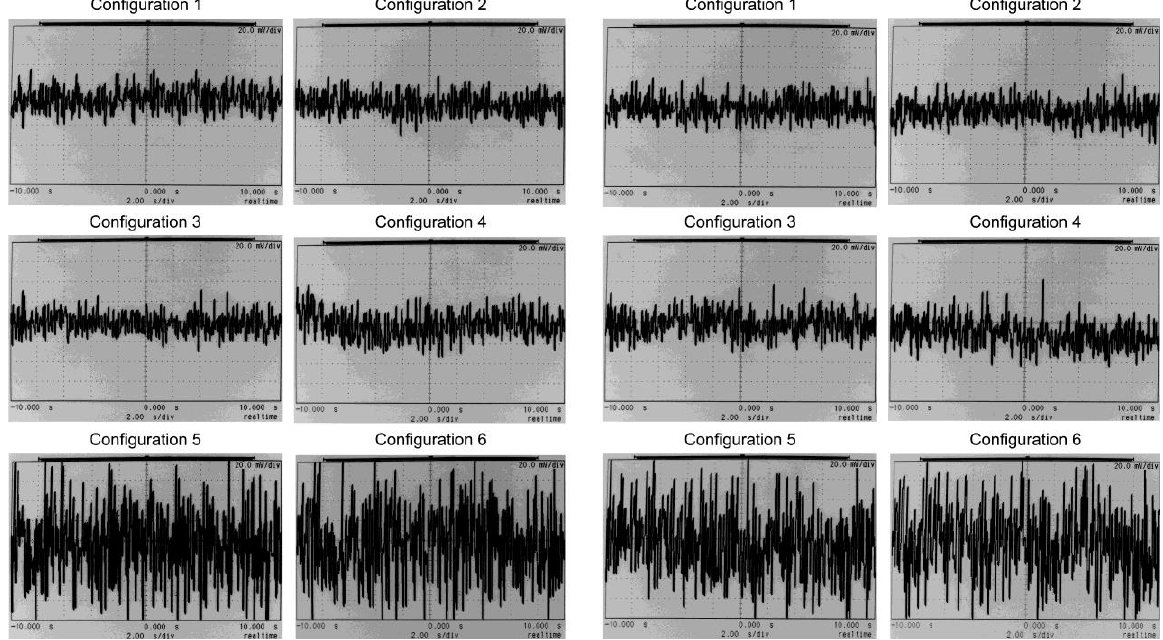
Figure 8. Noise graphs for the test circuit in Figure 5 at v for the HPF in Figure 4. On the right, configurations 1–6 for the HPF in Figure 3. Vertical span is 160 mV (20 mV/div). Horizontal span is 20